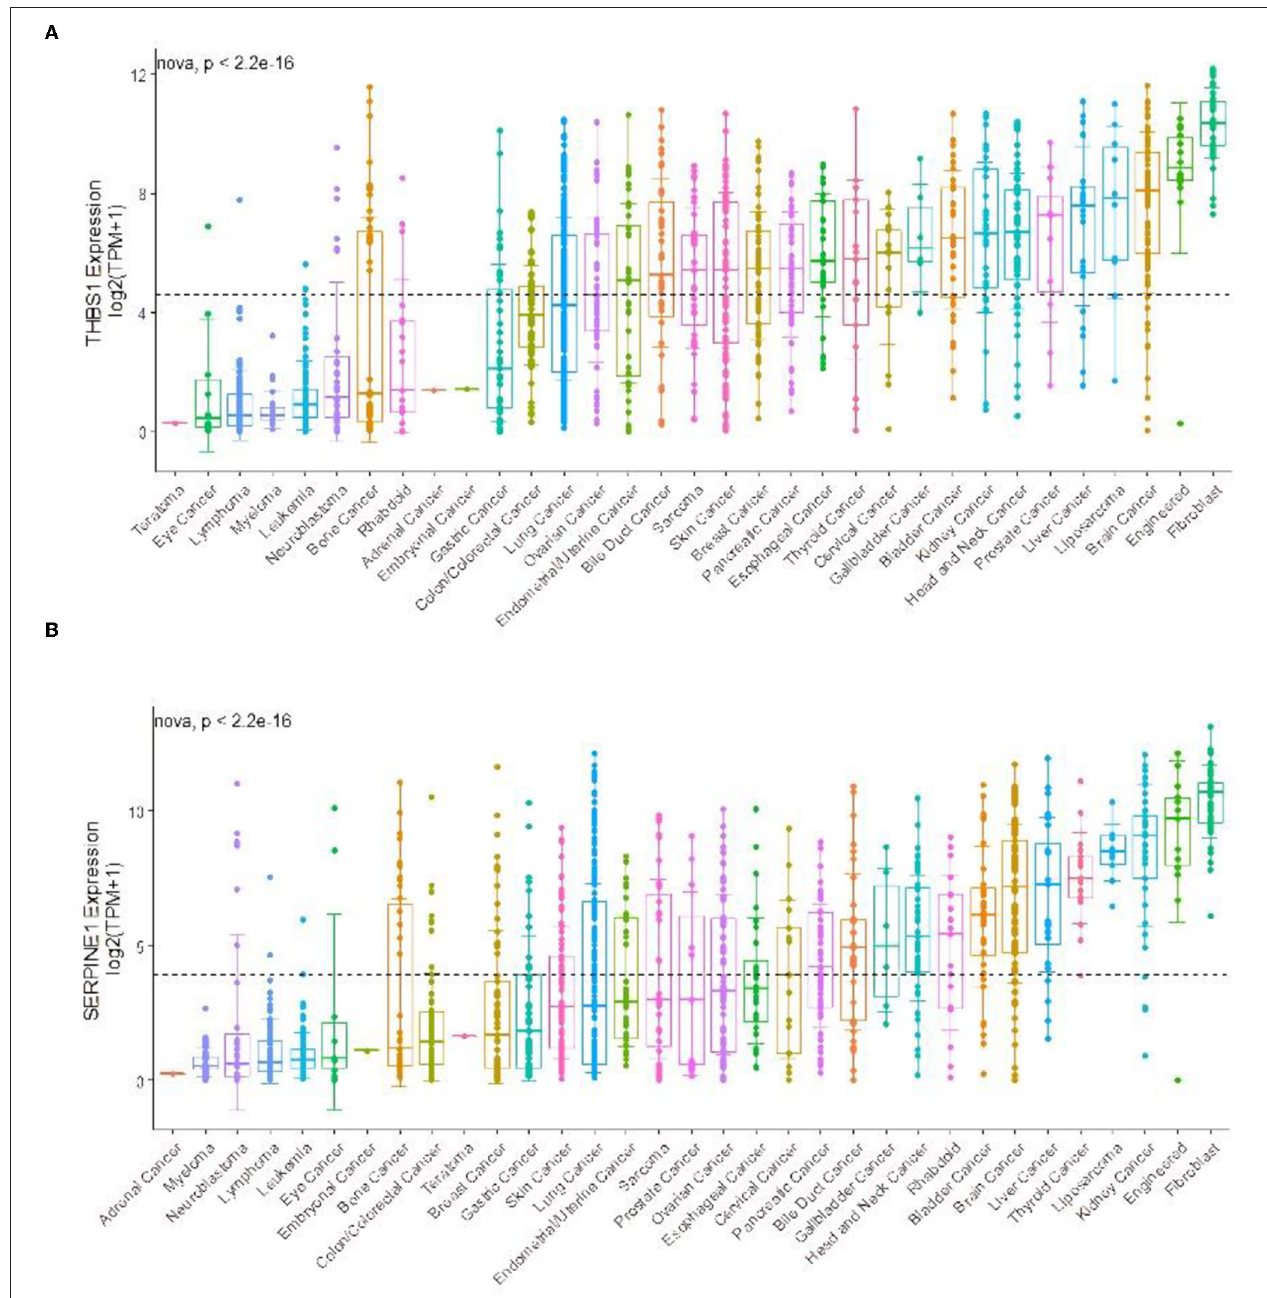
FIGURE 9 | Gene expression in different cancer cell lines for (A) THBS1 and (B) SERPINE1. The black dotted lines represent the average expression of all tumors, and the horizontal lines in the middle of each boxplot represent the median expression of individual tumors.